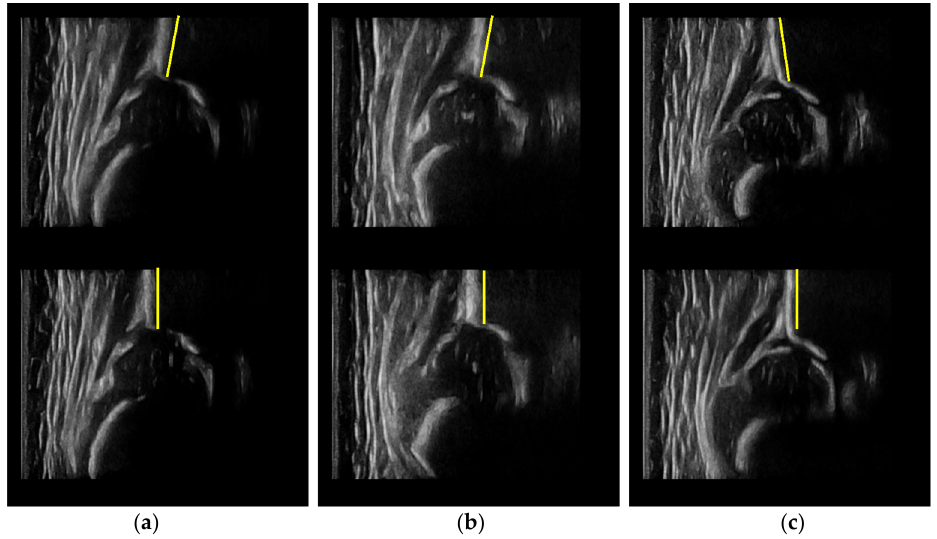
Figure 10. Comparisons of standard planes selected by DM w/o. SPSM ( upper ) and DM w. SPSM ( lower ). The ilia selected by DM w/o. SPSM are titled to the left ( a , b ), or the right ( c ), but the ilia selected by DM w. SPSM are all vertical and straight.